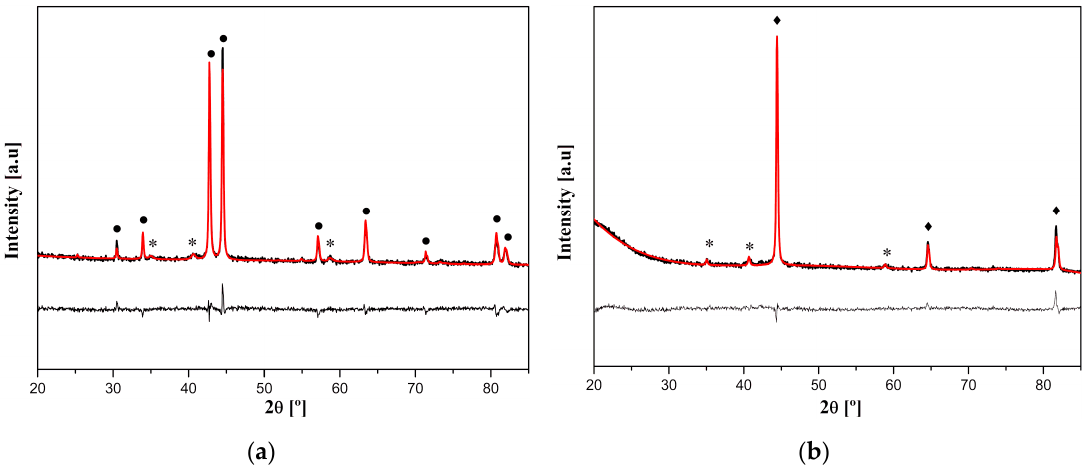
Figure 6. XRD patterns of samples milled for 100 h and heated up to 973 K at 20 K / min: ( a ) Si-free alloy ( b ) Si-containing alloy. Circles identify intermetallic phase, diamonds identify bcc solid solution and asterisks identify MnO phase. The experimental data are in black and the fitting in red. Corresponding di ff erences between the experimental and fitting curves are shown below each experimental pattern.